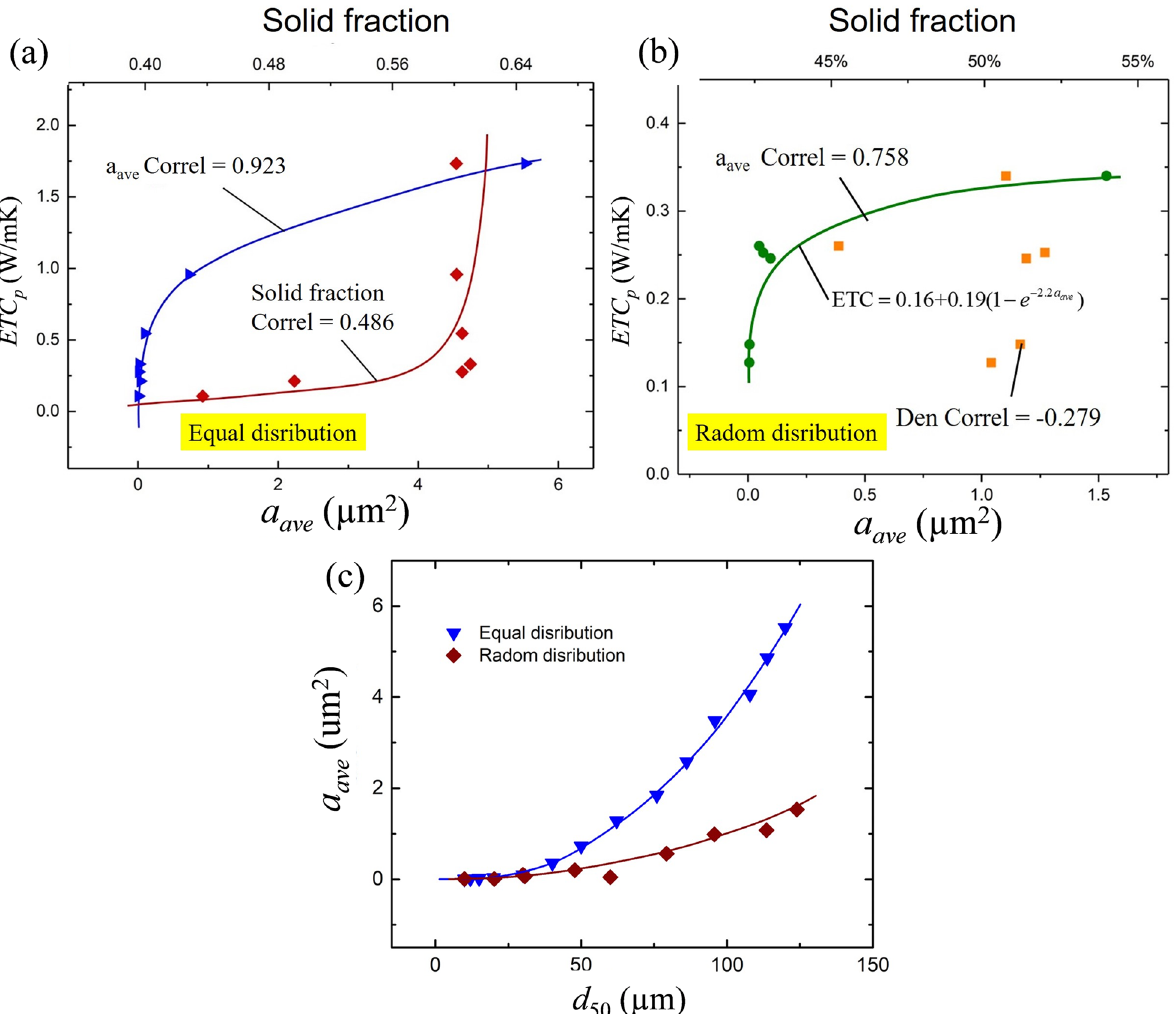
Figure 7 a Calculation results of equal particle size powder; b Calculation results of non-equal particle size powder; c Correlation between d 50 of particles and the average contact